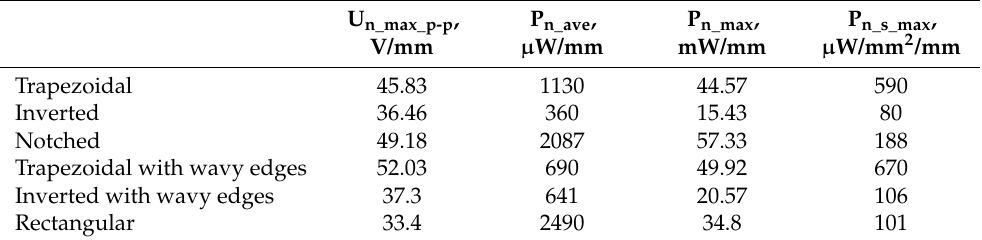
Table 8. Experimentally obtained voltages and powers normalized by the respective δ z